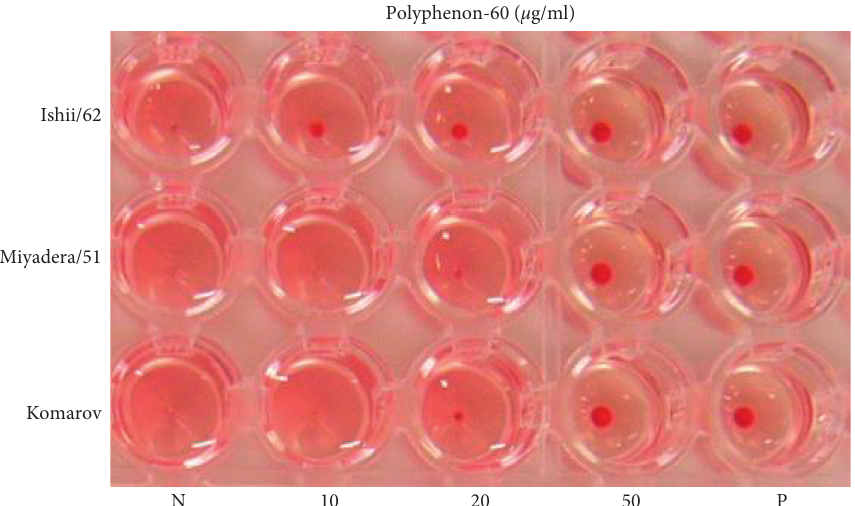
Figure 4: Inhibitory effect of polyphenon-60 on the hemagglutination of NDV strains. 4HAU NDV strains with three different pathotypes were incubated with polyphenon-60 at different concentrations (10 μ g/ml, 20 μ g/ml, and 50 μ g/ml). The well with untreated virus served as the negative control (N), and the well with only PBS served as the positive control (P). Three independent experiments were performed.